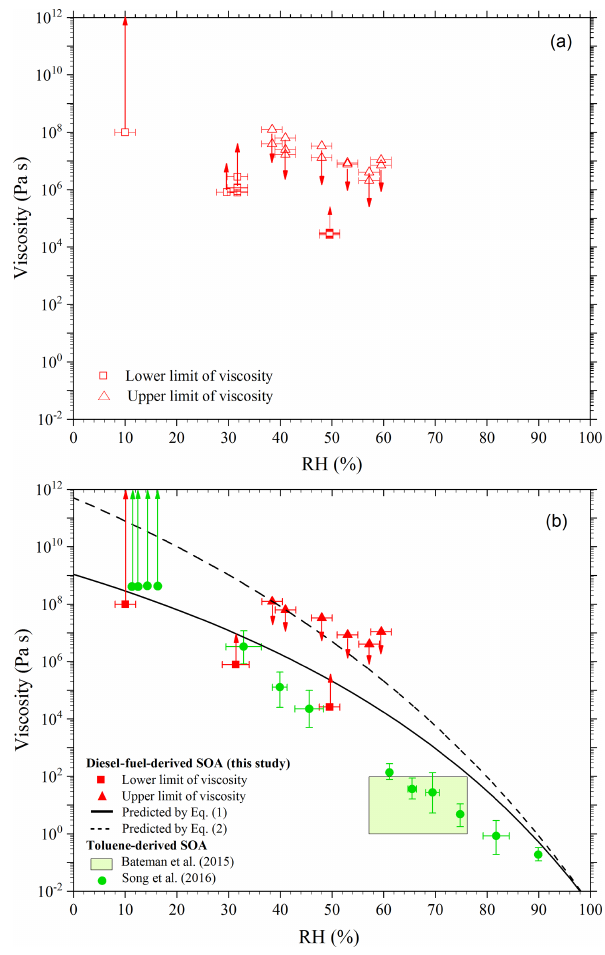
Figure 3. (a) Viscosities of diesel fuel SOA. Each data point corre- sponds to a viscosity determined from poking a single and different particle. Each particle was prepared with the same reaction con- ditions. Upward arrows indicate lower limit to the viscosities and downward arrows indicate upper limit to the viscosities of diesel fuel SOA. The x error bars represent uncertainty in the RH measure- ments. (b) Viscosities of diesel fuel SOA but with the viscosities from individual poke-and-flow experiments grouped by RH. The lower limit to the viscosities and the upper limit to the viscosities represent the lowest and the highest viscosities in the group, respec- tively. At least two data points were included in each group. The x error bars represent the lowest and highest RH ranges in the group and the uncertainty in the RH measurements. Also included are vis- cosities of toluene SOA from Bateman et al. (2015) (green box) and M. Song et al. (2016) (green circle symbols) and predicted vis- cosities of the diesel fuel SOA using Eq. (1) (solid black line) and Eq. (2) (dashed black